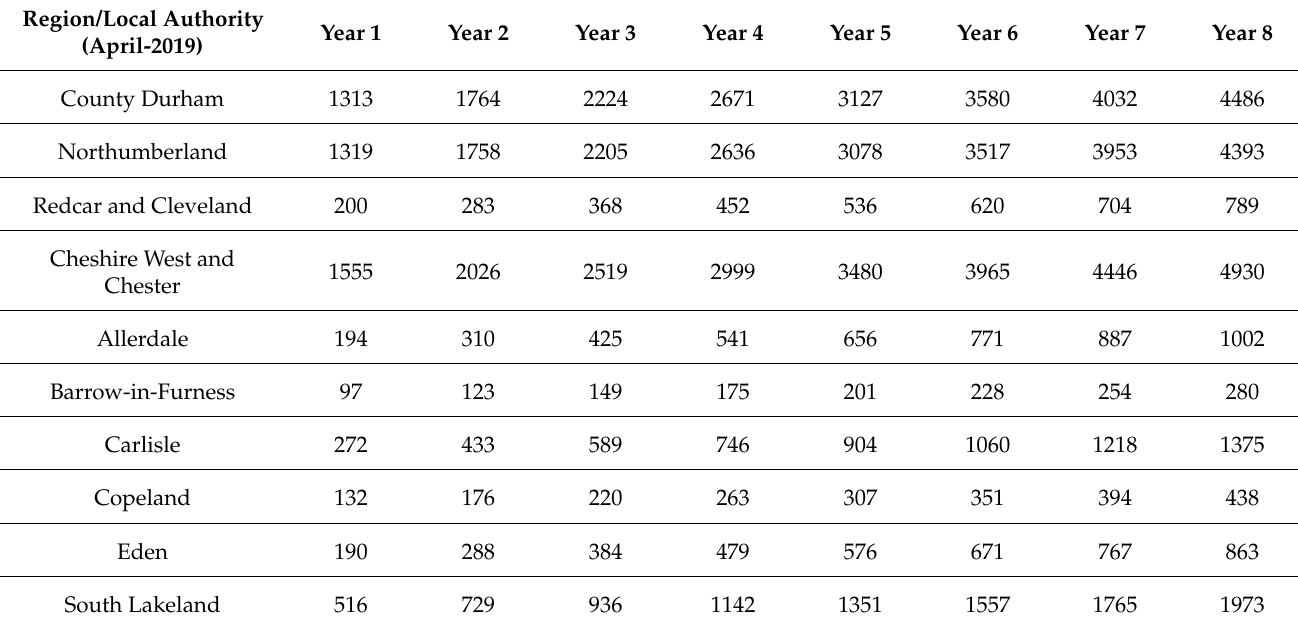
Table 13. Selection of E v data per